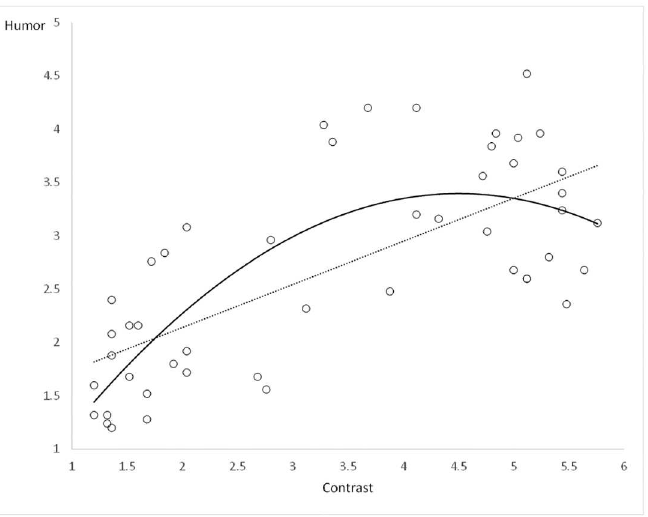
Fig 1. Scatterplot of contrast and humor degrees showing the linear (dash line) and quadratic (solid line) relationships.